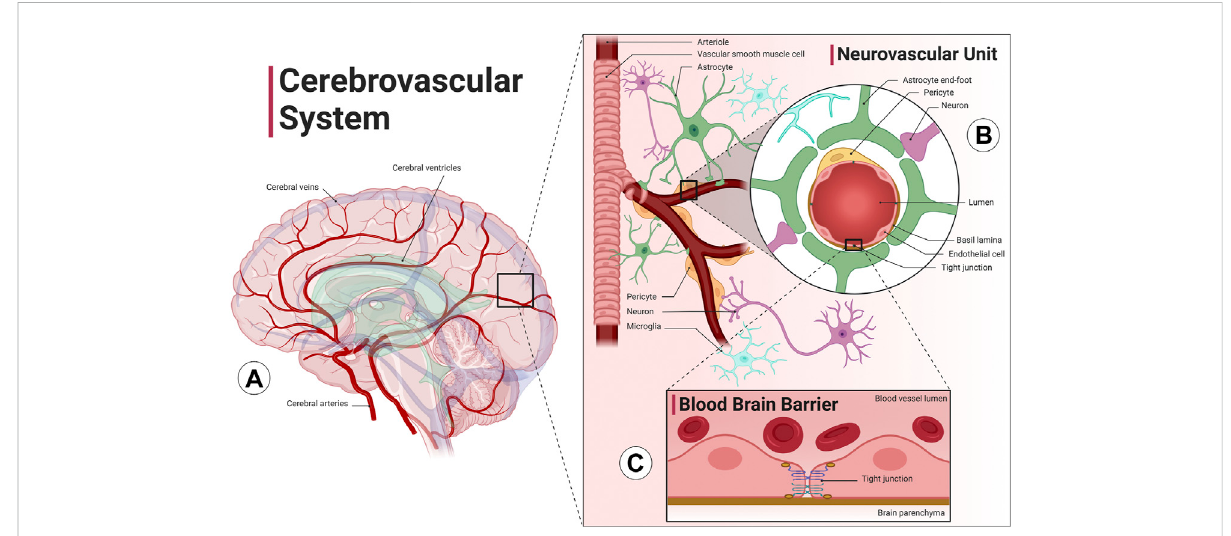
FIGURE 1 The cerebrovascular system. The cerebrovascular system is comprised of blood vessels that transport blood to and from the brain. (A) The cerebral arterial system (red) has four main arteries that supply the brain, the internal carotid arteries, which run along the neck and provide blood to the anterior cerebral cortex, and the vertebral arteries, which run along the spinal column and provide blood to the posterior cortex and the brainstem. The anterior and posterior cerebral circulation converge at the Circle of Willis, a group of blood vessels that anastomose at the base of the brain. The cerebral venous system (blue) includes super fi cial and deep veins that ultimately drain into two jugular veins at either side of the neck. Interconnected cavities called the cerebral ventricles (green) are fi lled with cerebrospinal fl uid (CSF) and are involved with the brain ’ s unique waste management system, the glymphatic system. (B) The intracranial arteries branch and dive deep into the cortex, forming the intracerebral perforating arteries. Cerebral arterioles include vascular smooth muscle cells that allow the vessel to vasodilate or vasoconstrict in order to increase or decrease fl ow to the brain parenchyma. The neurovascular unit, consisting of blood vessels, neurons, astrocytes, pericytes and microglia cells, preciselyregulatescerebralblood fl owtomatchneuronalmetabolicdemand. (C)